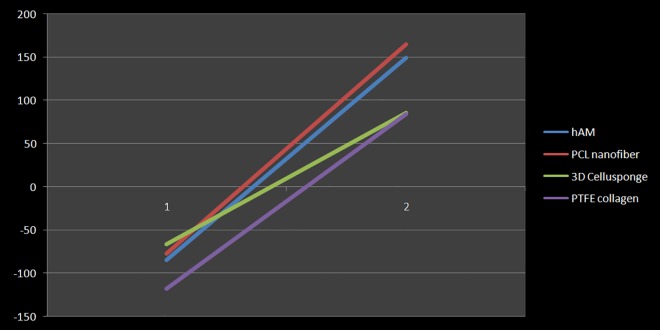
Surface Characterization of the Decellularized hAM Based Platform.A line diagram illustration of the 3D surface roughness parameter (R) of each scaffold characterized using SurfaceJ. It shows the span between the lowest valley (1), and the highest peak (2) in each scaffold. Detailed SurfaceJ characterization is shown in supplementary information (S1 File).